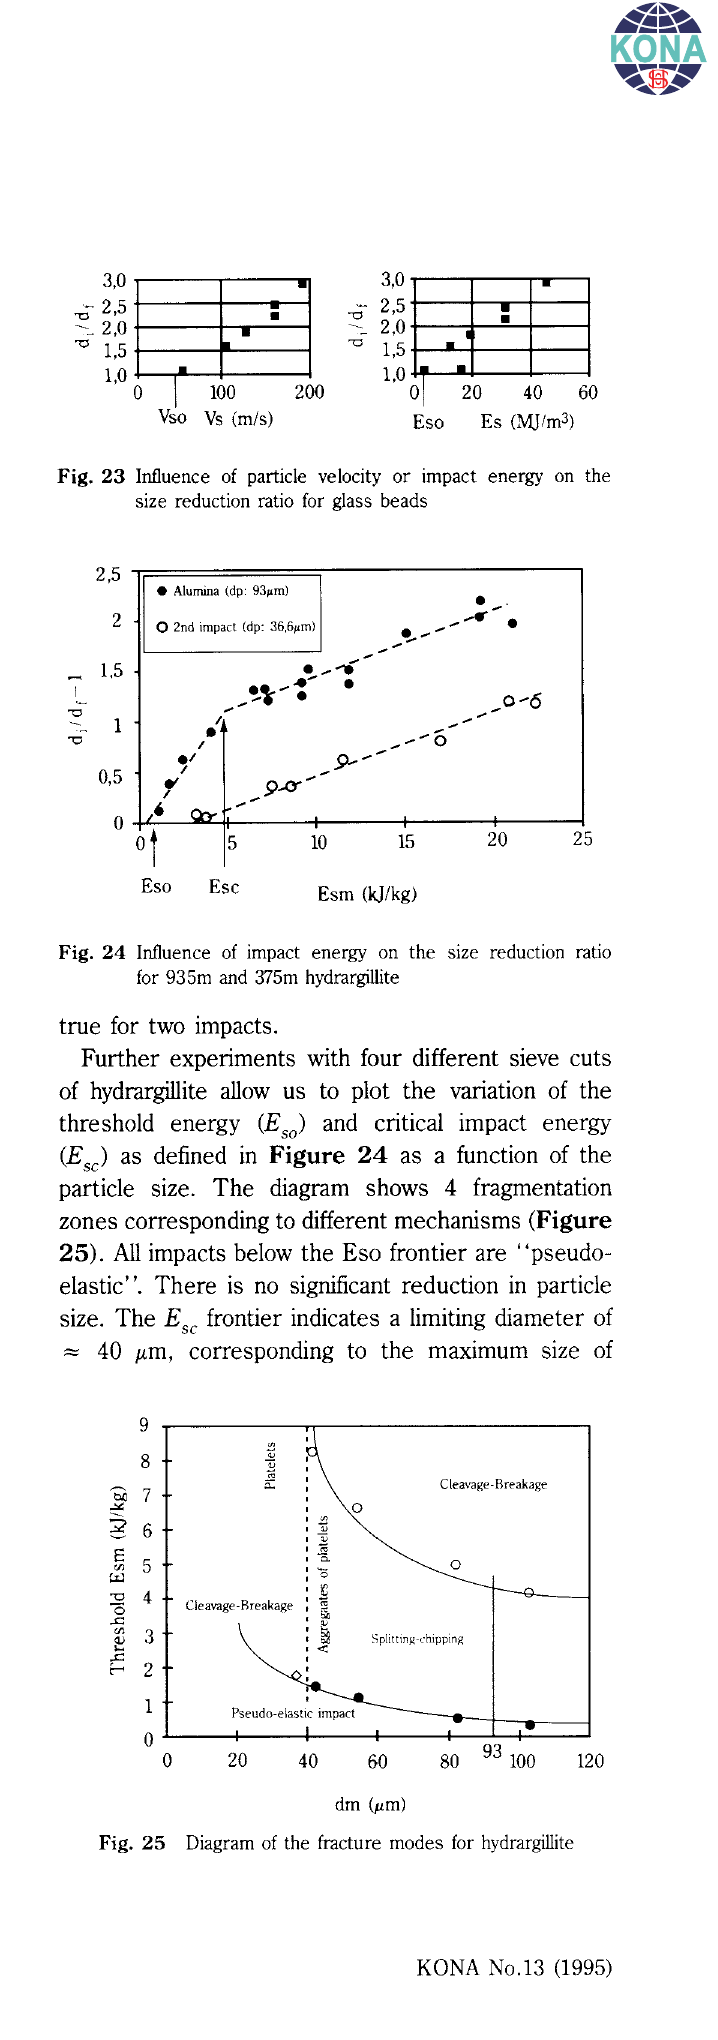
Fig. 25 Diagram of the fracture modes for